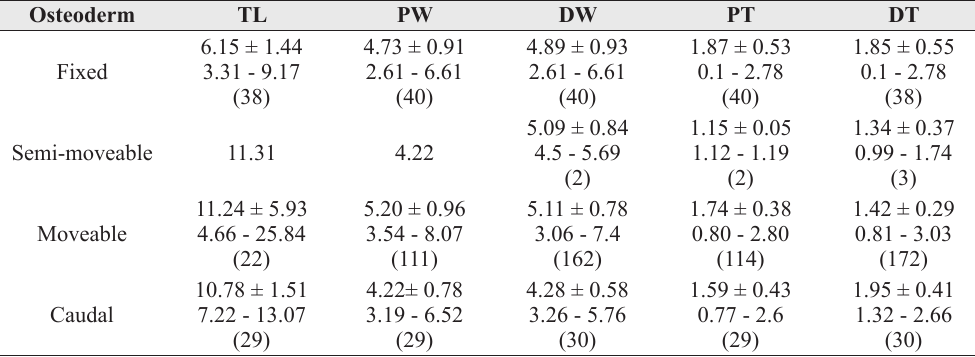
Measurements (mm) of preserved osteoderms assigned to Dasypus aff. D. novemcinctus. Abreviations: TL, total length; PW, proximal width; DW, distal width; PT, proximal thickness; DT, distal thickness. When n >1, first line is mean ± standard deviation, second line is observed range, and third line is number of specimens measured